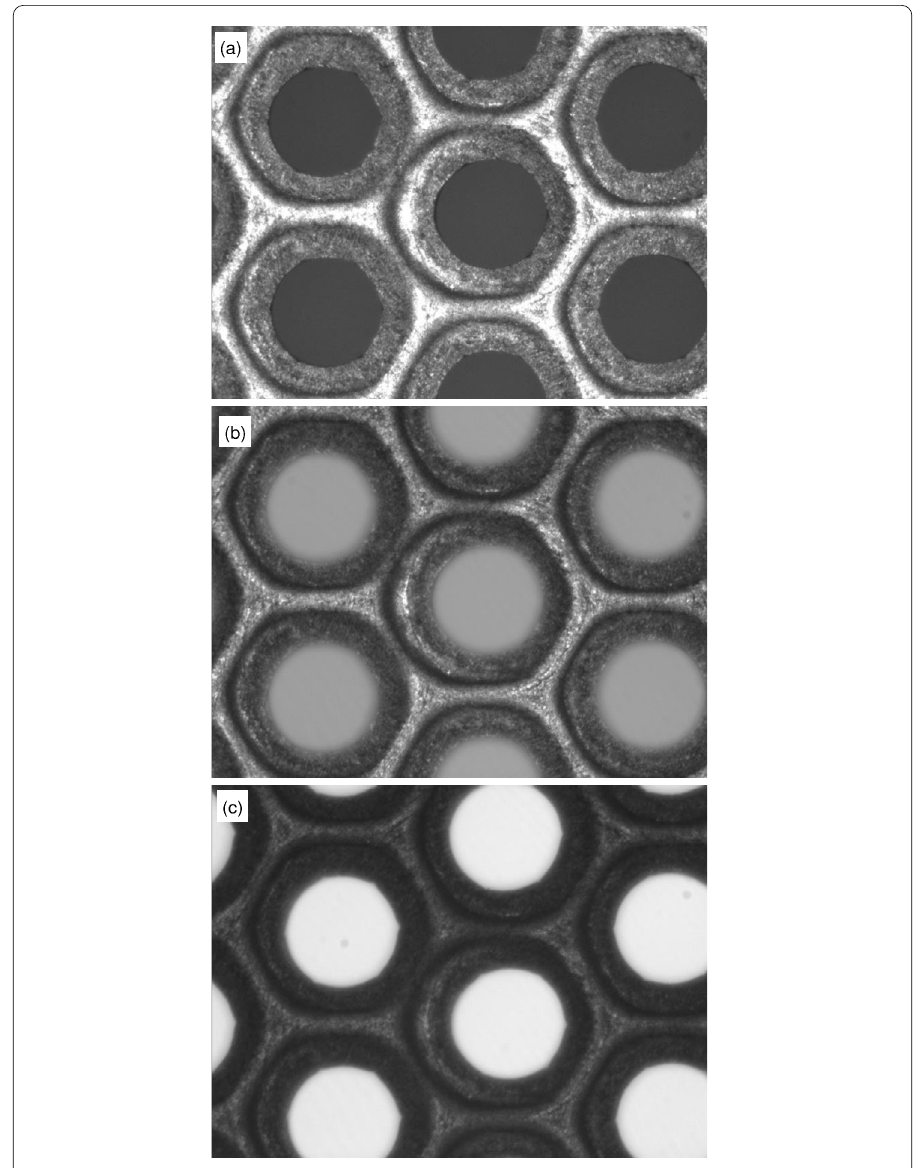
Figure 13 Telemicroscope images of grid holes of the RIT-22 at different operation stages: thruster off ( a ), plasma on ( b ), and beam on ( c